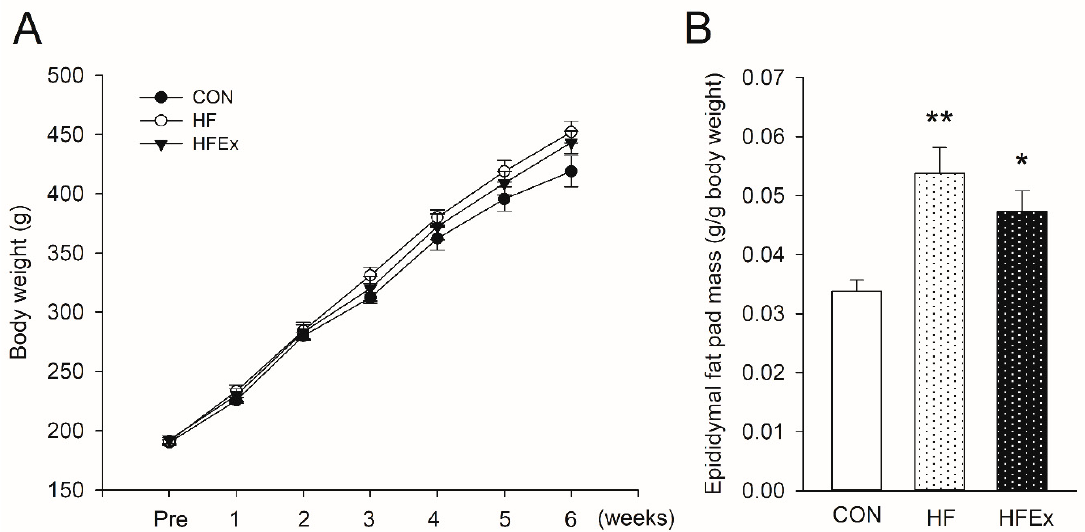
Figure 1. The impact of high-fat diet (HFD) or HFD and exercise. Changes in body weight ( A ) and epididymal fat pad mass ( B ) over 6-week treatment. Data are presented as means ± SEM. Data was analyzed by a two-way ANOVA with repeated measures ( A ) and one-way ANOVA ( B ). * p < 0.05 vs. control (CON), ** p < 0.001 vs. CON. CON, control; HF, HFD intake; HFEx, high-fat diet with low-intensity endurance exercise.